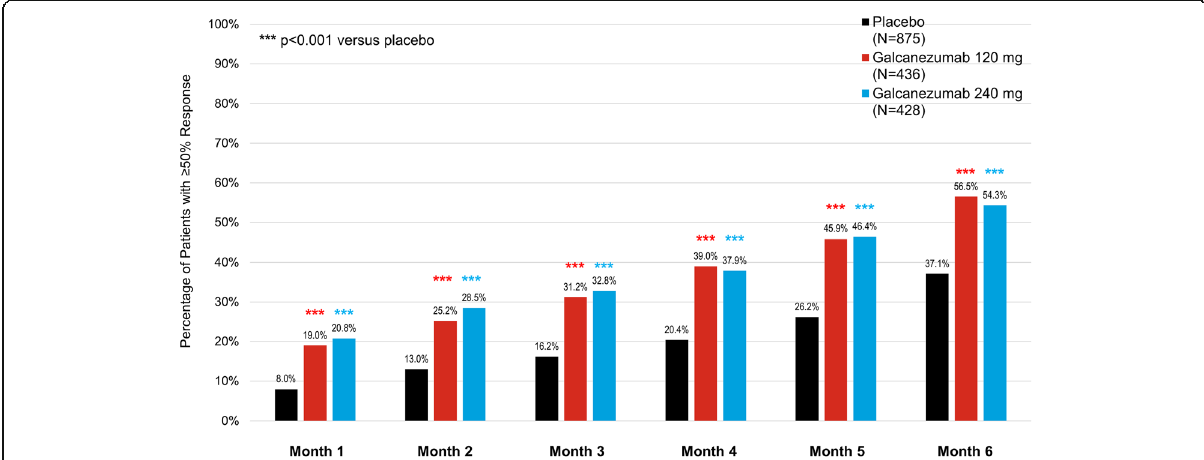
Fig. 3 Cumulative maintained ≥ 50% response: percentages of patients with episodic migraine who reached ≥ 50% response at or before each month and all subsequent